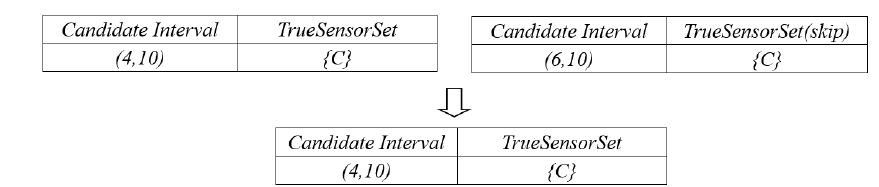
Figure 8. Example in Phase III.